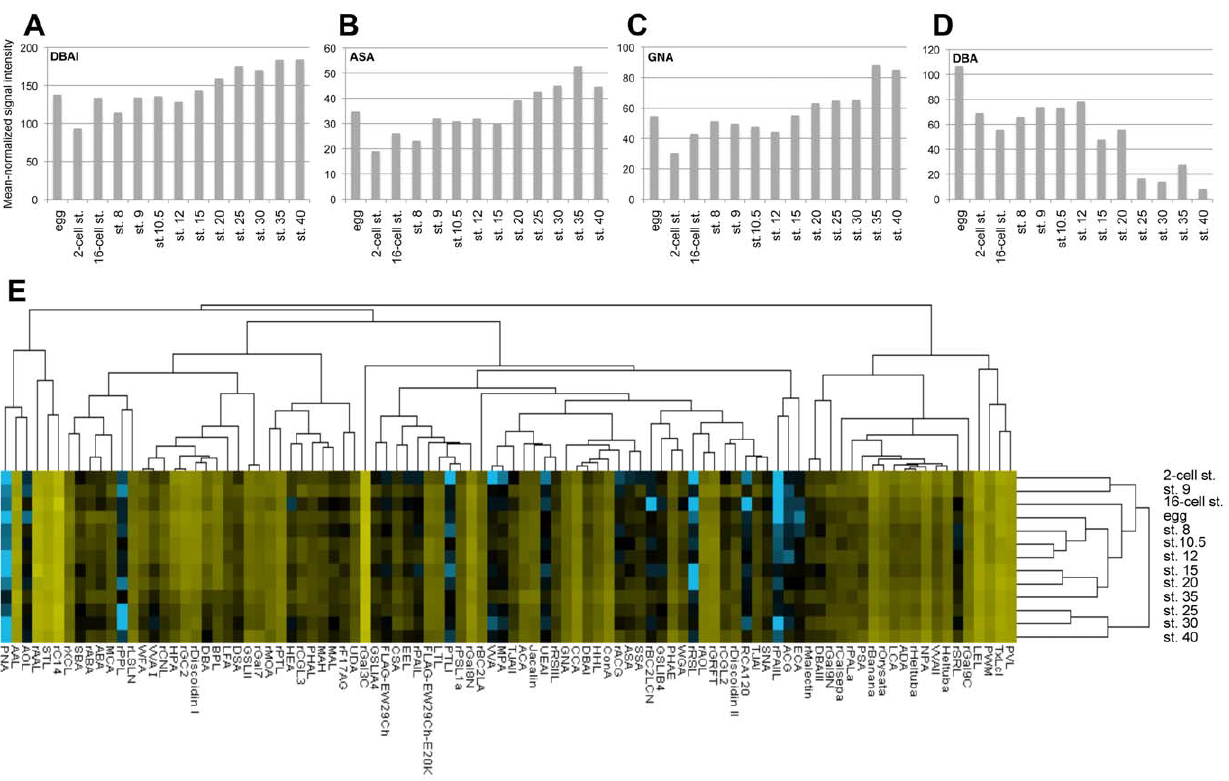
Figure 1. Lectin microarray data of Xenopus embryogenesis. (A–D) Lectin microarray data for the 4 indicated lectins, DBAI (A), ASA (B), GNA (C), and DBA (D). Mean-normalized signal intensities of lectins are shown. All lectin data are shown in Table S3. (E) A summary of 96 lectin signals. Unsupervised hierarchical cluster was generated using mean-normalized and log-transformed signal intensities. Levels of lectin signaling are indicated by a color change from blue (low) to yellow (high). Egg, unfertilized egg; st., stage.